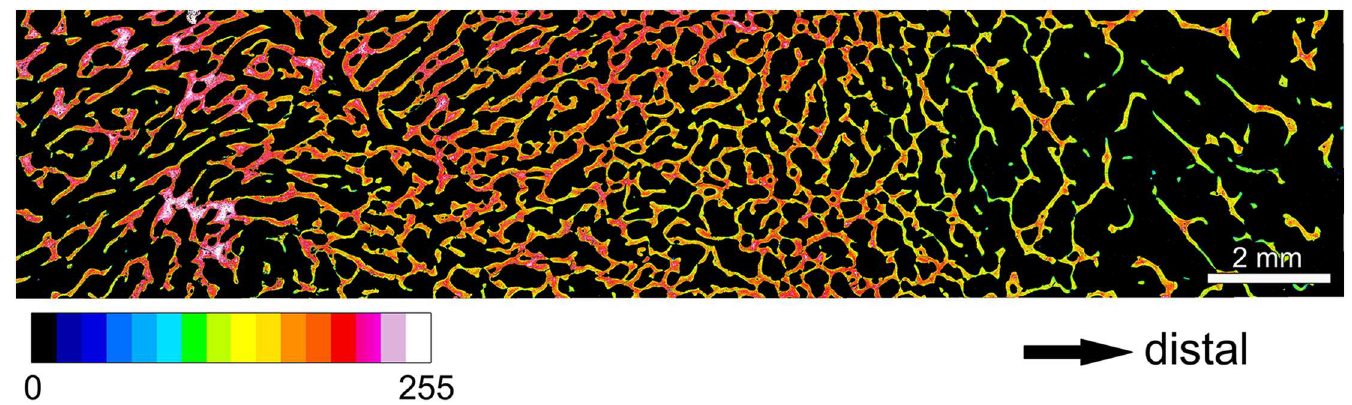
Fig 6. Stitched pseudo-color BSE image of the proximal portion (stalk region) of the smaller exostosis arising from the right antler of the white-tailed buck ( Odocoileus virginianus ). For location see Fig 2A. The gray levels from black (0) to peak white (255) obtained in the SEM were sequentially combinedinto16 bandsof equal width, each represented by a different color (see inserted color bar). Highervalues indicatehigherdegreesof mineralization. Note increasingtissue porosity and decreasing degreeof mineralization of trabeculaein distal direction.